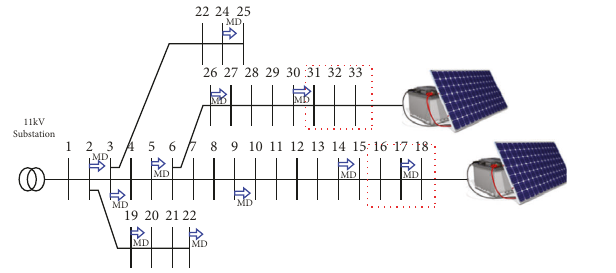
Figure 12: Block diagram of IEEE33 Bus with Distributed Generation. Table 14: M ean entropy values of various fault